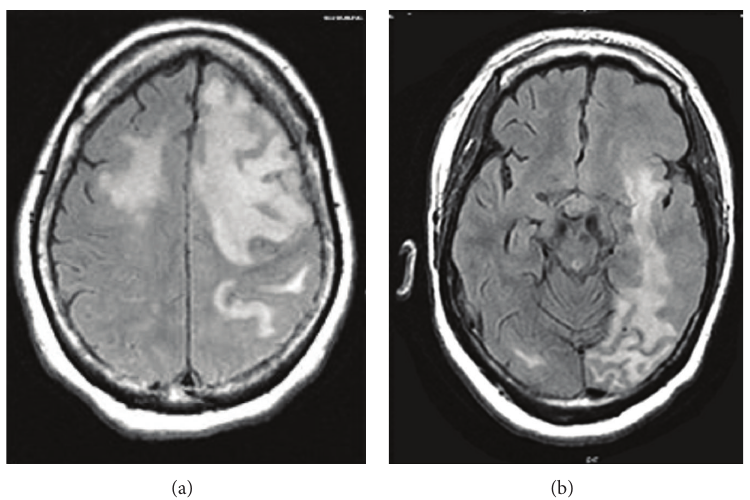
Figure 3: MRI brain-diffuse increased FLAIR signal throughout the left cerebral